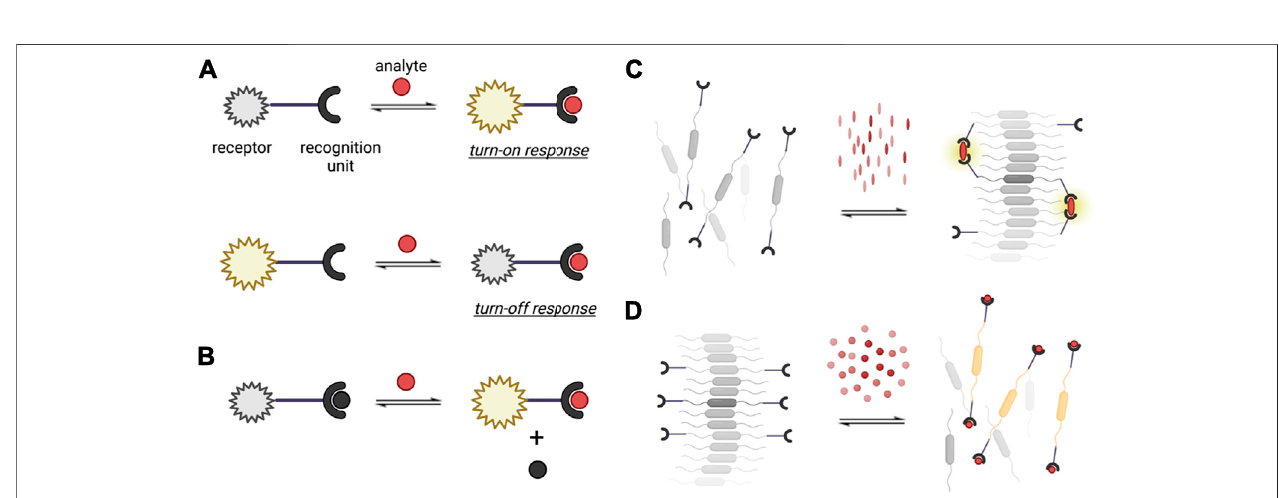
FIGURE 2 | Different recognition mechanisms utilized in supramolecular analytical chemistry. (A) Direct sensing, illustrating a turn-on and turn-off response; (B) indicator displacement sensing; and sensing based on supramolecular (C) assembly/ (D) disassembly.